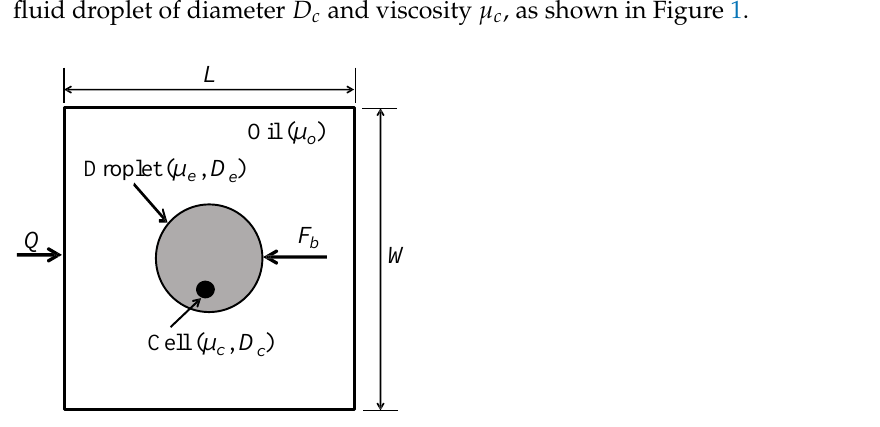
Figure 1. Modeling of rotational flow of a single cell is encapsulated inside an